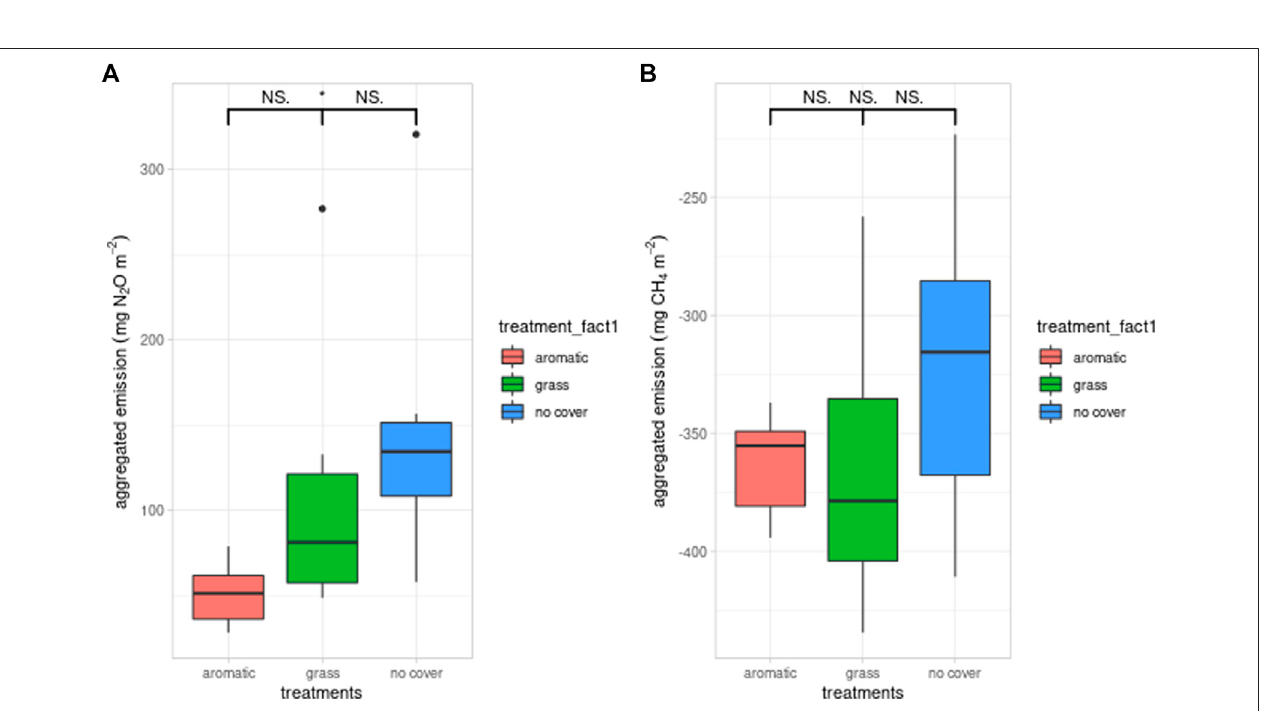
Frontiers in Environmental Science |